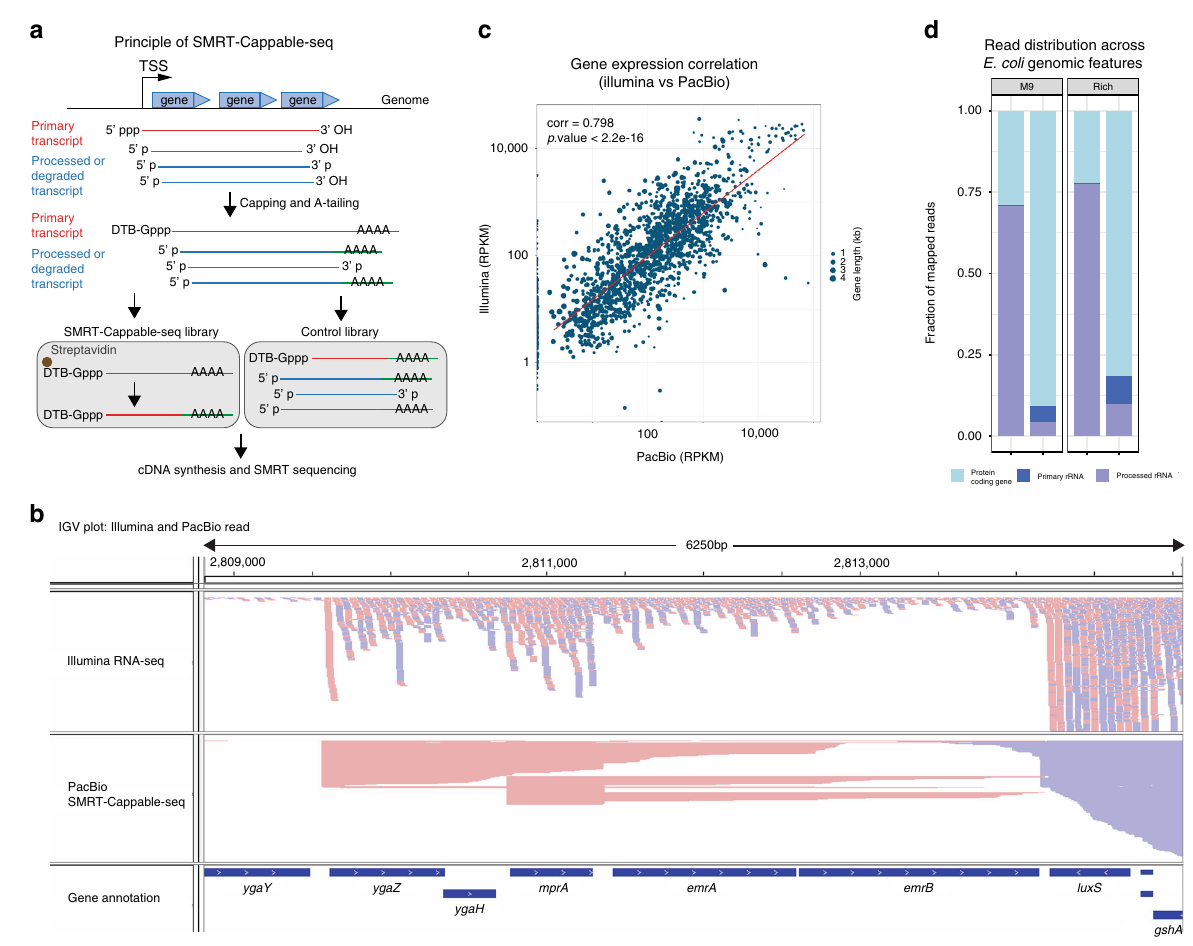
Fig. 1 SMRT-Cappable-seq identi fi es full-length transcripts in bacteria. a Schema of the SMRT-Cappable-seq methodology. 5 ′ triphosphorylated transcripts are capped with a desthio-biotinylated (DTB) cap analog and bound to the streptavidin beads to speci fi cally capture primary transcripts starting at TSS. The polyadenylation step (A-tailing) ensures the priming of the anchored poly dT primer for cDNA synthesis at the most 3 ′ end of the transcript. b